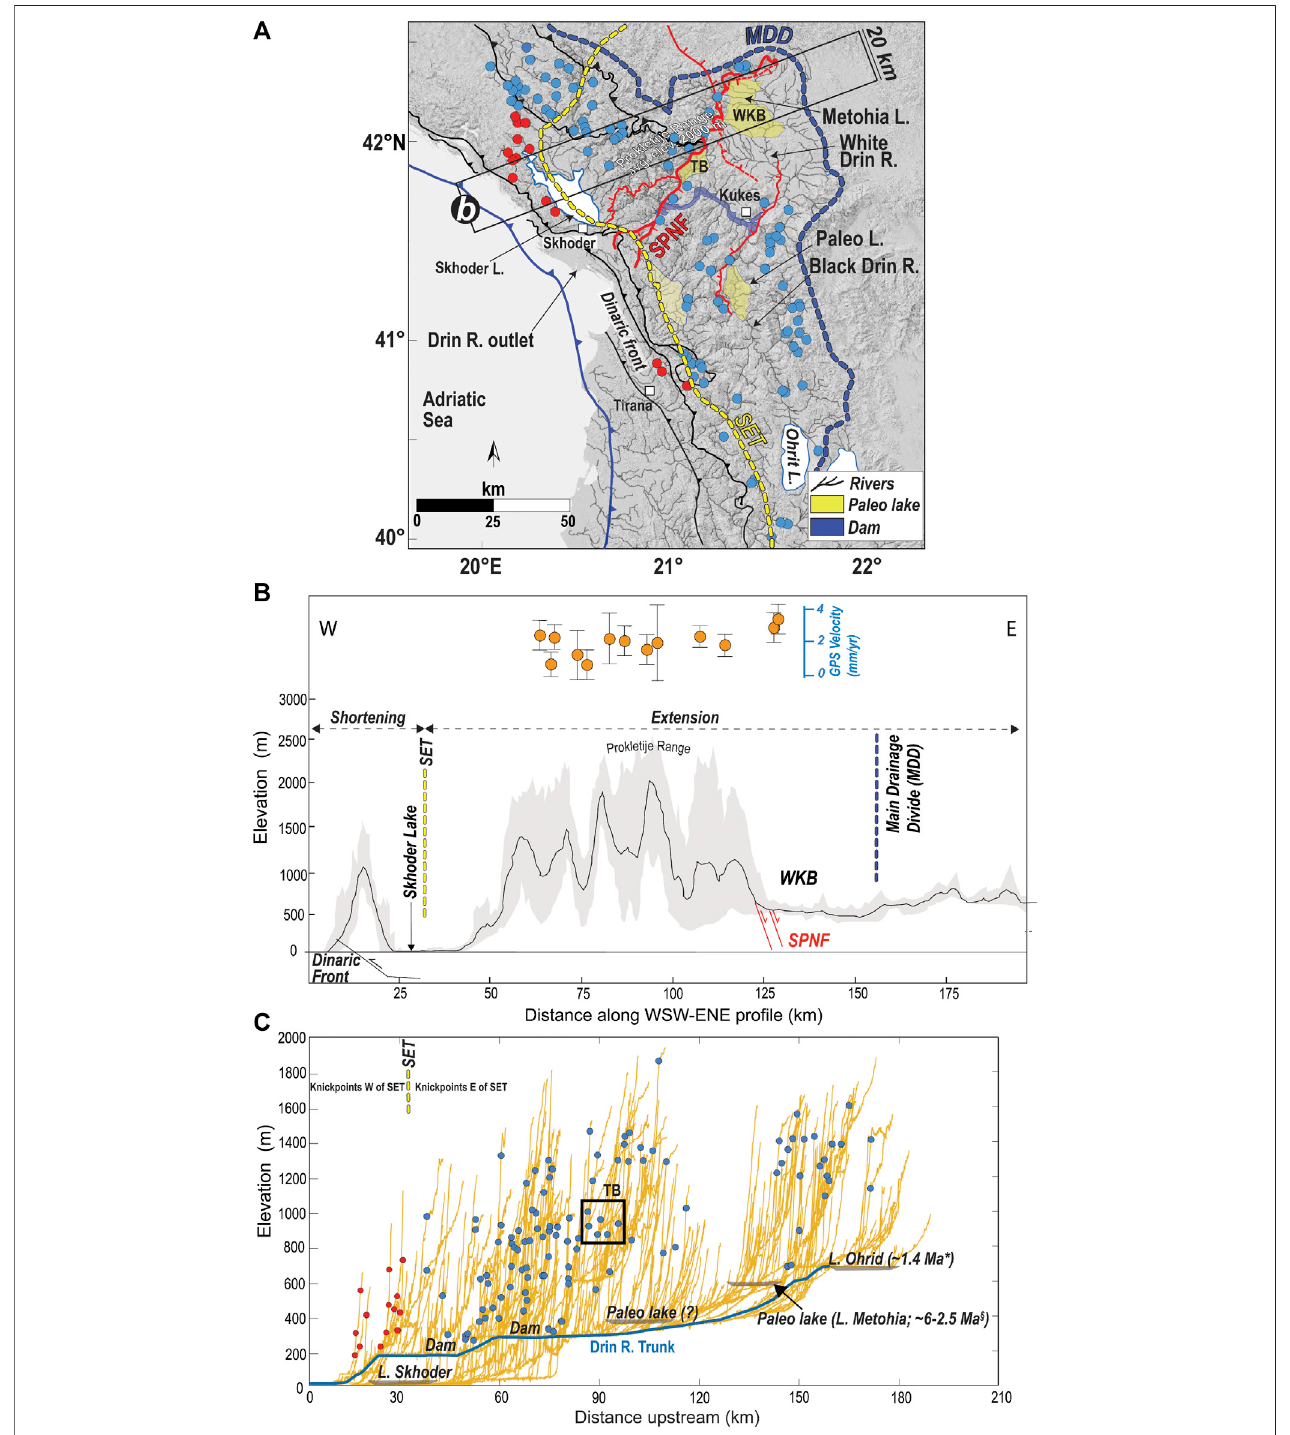
FIGURE 8 | Distribution of knickpoints and relief (de fi ned as the difference between the min and max elevations) at the Dinarides-Hellenides junction: (A) Hillshade map based on SRTM-1 arc-second DEM (USGS, 2014); Additional elements are river streams (black lines), the trace of the shortening-extension transition (SET – yellow dashed line), main drainage divide (MDD – blue dashed line). Knickpoints to the west and east of the SET are colored, respectively, red and blue. The base-level is the outletoftheDrinRiverintotheAdriaticSeaaslabelledin(a); (B) 20-kmwideswathpro fi lewithmaximumandminimumelevationsatupperandlowerboundariesof the grey area, respectively. The mean elevation is represented as a solid black line. Faults - normal (red) and thrust (black). GPS velocities given in mm/yr (orange dots) withtheir relativeerrors asaverticalline.GPSdatain(b)arefromD ’ Agostino et al.(2020); (C) Longitudinalriverpro fi lesand locations ofknickpoints identi fi edin(a),0 km on the x -axis is the Drin River outlet, the reference level used in the calculation of knickpoints. Paleo-lakes are indicated as grey polygons. Age estimates of Lake Ohrid (~1.4 Ma – to-Present) taken from Wagner et al. (2019) and of the paleo-Metohia Lake in the Western Kosovo Basin (WKB) from Neubauer et al. (2015b).